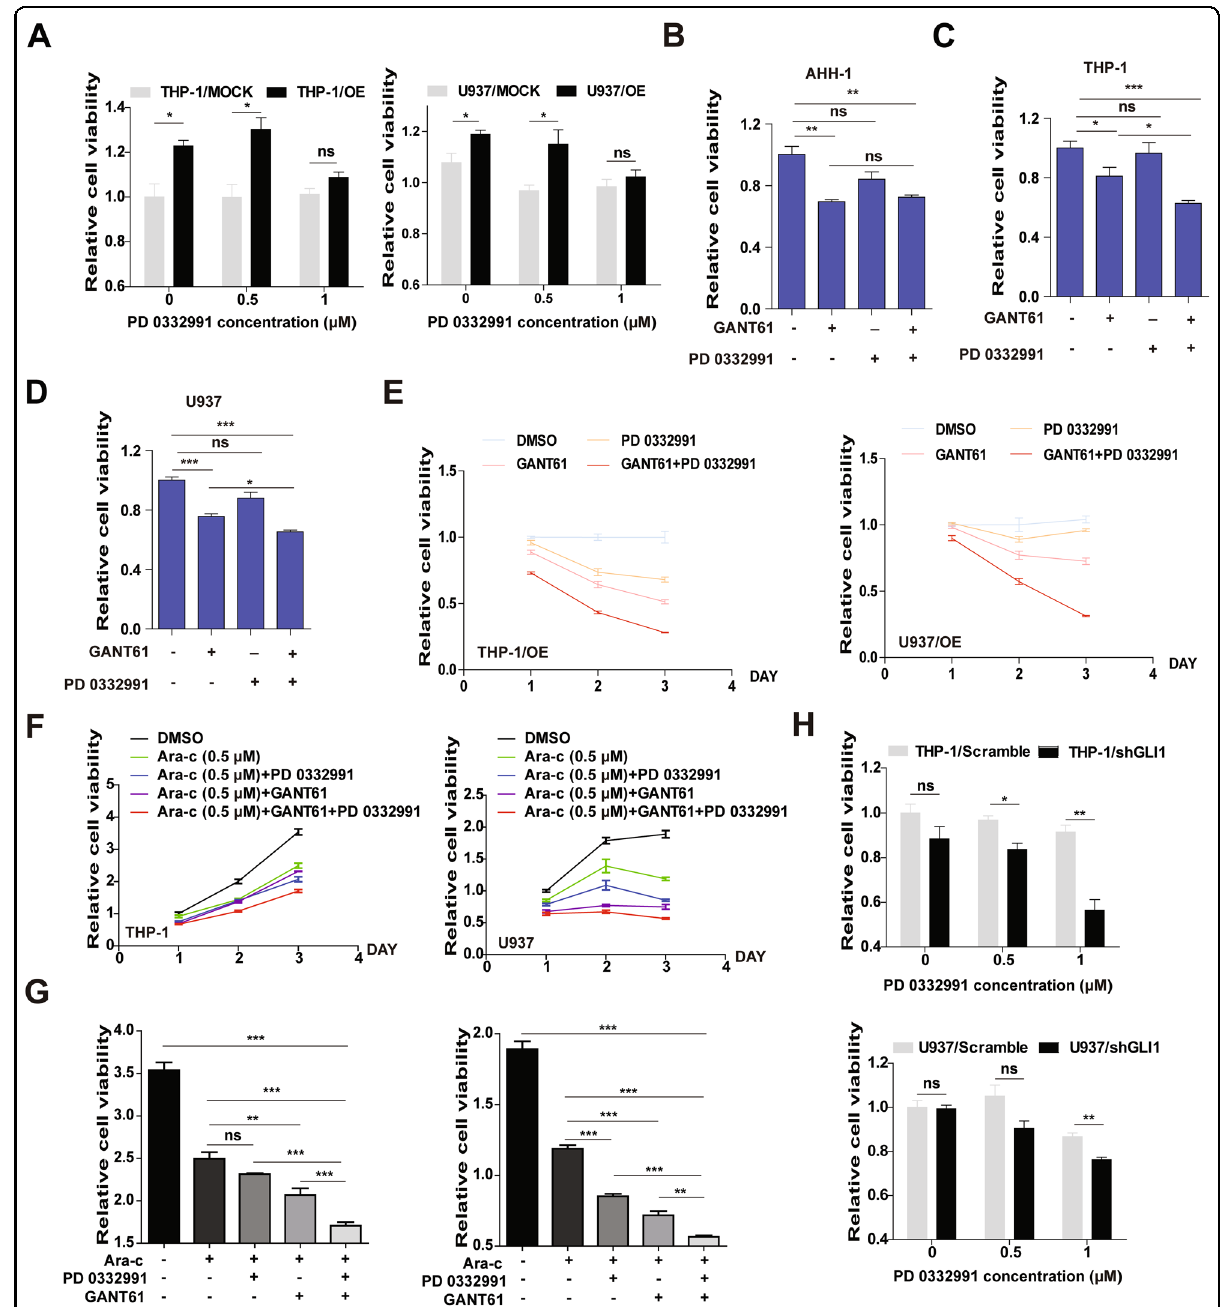
Fig. 5 Inhibition of GLI1 and CDK4/6 had a synergistic effect on promoting drug sensitivity and reducing cell viability in AML cell lines. A Relative cell viability of THP-1 and U937 MOCK/ OE cells after treatment with different concentrations of PD 0332991 (0, 0.5, and 1 μ M) for 48 h. B – D Relative cell viability of the normal lymphocyte cell line (AHH-1) ( B ) and the AML cell lines THP-1 ( C ) and U937 ( D ) after treatment with GANT61 and/or PD 0332991 for 24 h. E THP-1/OE and U937/OE cells were treated with GANT61 (20 μ M) and/or PD 0332991 (0.5 μ M) for 24, 48, and 72 h. Cell viability was determined by CCK8. F Relative cell viability of THP-1 (left) and U937 (right) cells in response to different combinations of drugs. Ara-c, PD 0332991, and GANT61 were added at concentrations of 0.5, 0.5, and 20 μ M for 24, 48, and 72 h. Cell viability was determined by CCK8 at the indicated time points. G Statistical analysis of cell viability at 72 h in ( F ). H Relative cell viability of THP-1 and U937 Scramble/shGLI1 cells after treatment with different concentrations of PD 0332991 (0, 0.5, and 1 μ M) for 48 h. The P values were obtained by a two-tailed Student ’ s t -test and two-way ANOVA. * P < 0.05, ** P < 0.01, *** P < 0.001, ns not signi fi